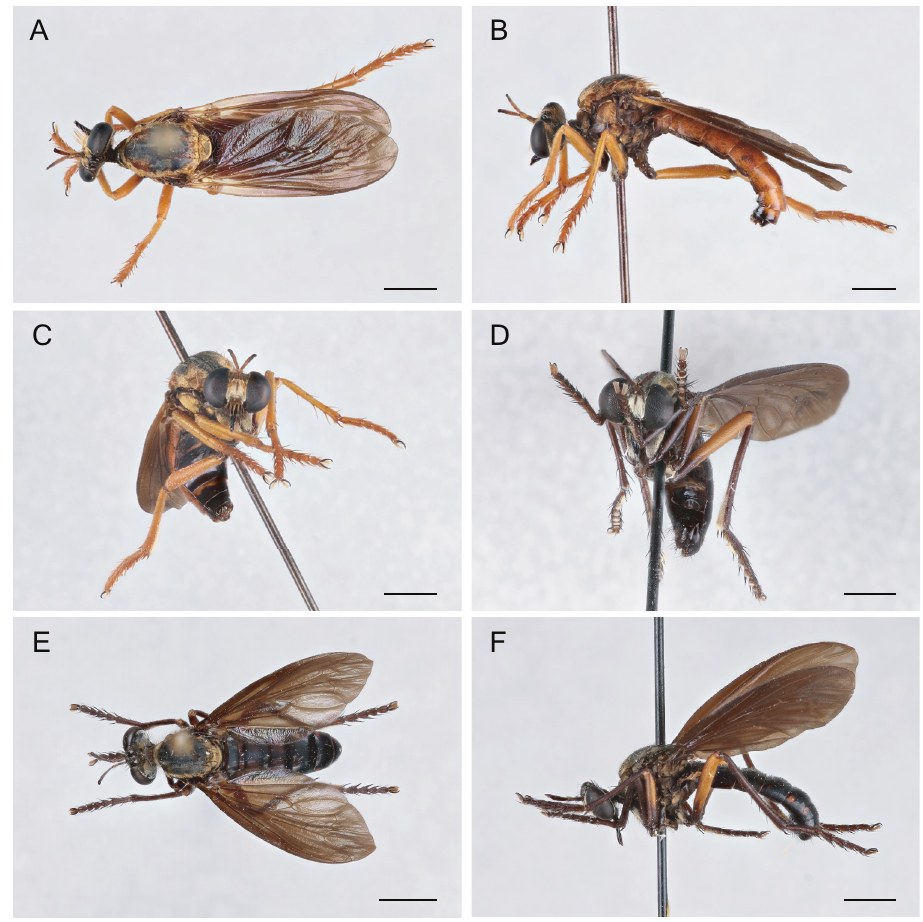
Figure 21. Saropogon purus Curran, 1930 Female (UCBMEP0280564): A dorsal view B lateral view C anterior view; Male (USNMENT01830082): D anterior view E dorsal view F lateral view. Scale bars: 2